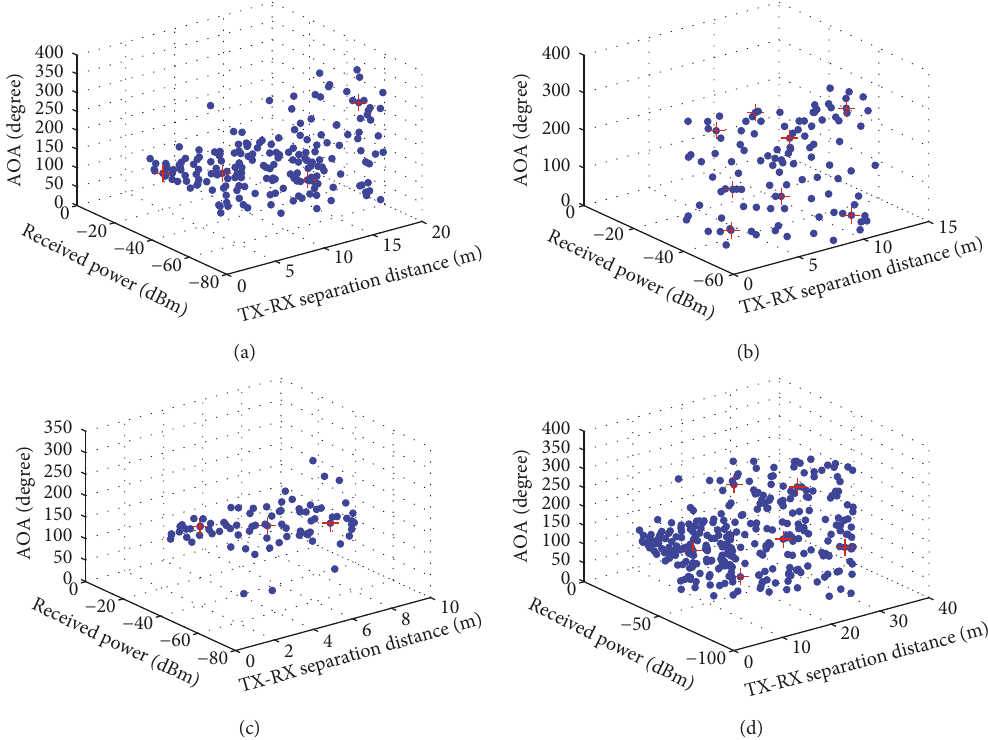
Figure 10: Mean AOA in tunnel scenarios. (a) LOS-1 path, (b) LOS-2 path, (c) LOS-3 path, and (d) NLOS path. Table 5: AOA parameters for all scenarios. Cluster Scenarios